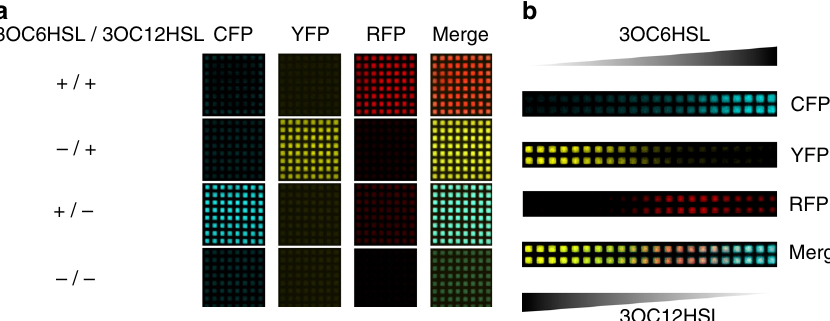
Fig. 5 HSL-responsive surface-based patterning of bacterial gene expression. a Surface-based circuit behavior in response to HSLs present in the growth medium at uniform concentration. TOP10 E . coli co-transformed by the RFP reporter plasmid p4g3R and the improved bicistronic controller plasmid pCRB DRT7VTPLux*250 (see Fig. 3) were incubated on membranes printed with hydrophobic ink, placed on minimal agar containing different combinations of 3OC6HSL (25 μ M) and 3OC12HSL (1 μ M). Images shown were captured at t = 1500 min (time relative to start of incubation). Corresponding corrected fl uorescence intensities are shown in Supplementary Figure 9. b Surface-based AND gate behavior in response to HSL gradients. TOP10 E . coli cells co- transformed by controller and reporter plasmids as above were incubated on membranes placed on minimal agar lacking supplemented HSLs. Instead, aqueous solutions containing 500 μ M 3OC6HSL or 200 μ M 3OC12HSL, respectively, were spotted next to the cells on either side and left to diffuse into the bacterial population from opposite directions. Images shown were captured at t = 3000 min (time relative to start of incubation). Corrected fl uorescence intensities recorded over time are shown in Supplementary Figure